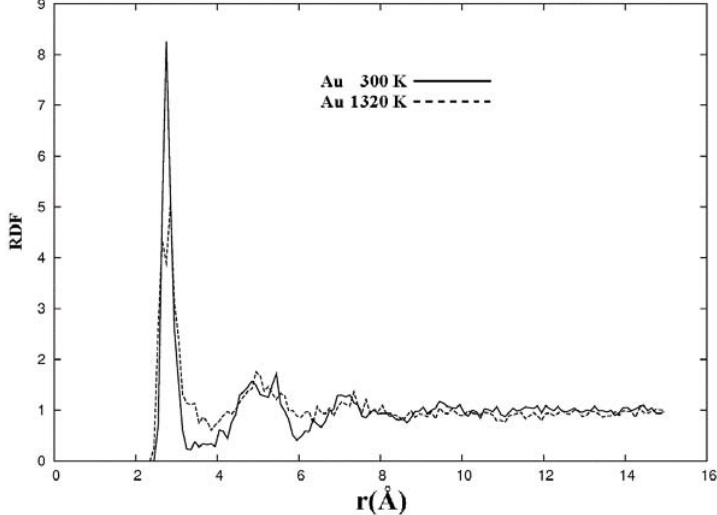
Figure 24. Radial (pair) distribution functions, RDFs, for 50% porosity supercells with 108 gold atoms after 500 steps of MD processes at 300 K and at 1,320 K. See text.